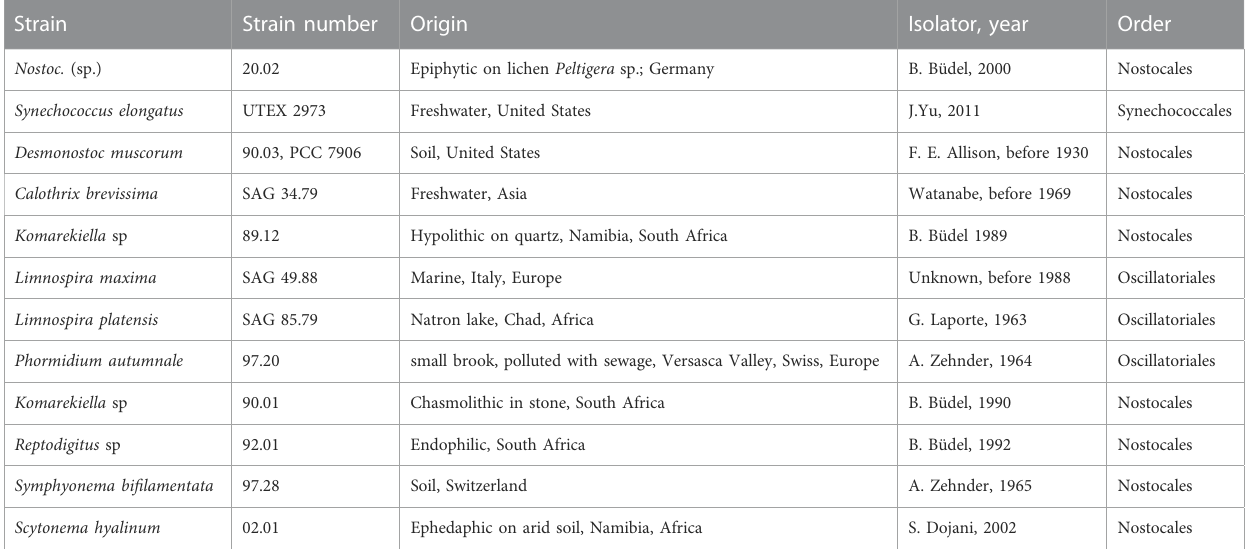
TABLE 1 Overview of all investigated cyanobacteria strains in this study. Strain Strain number Origin Order Nostoc. (sp.)